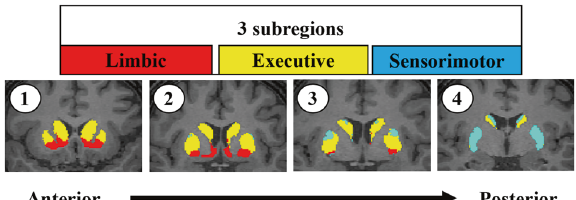
Fig. 1 Region of interest in the striatum. Striatal atlas re fl ecting the probabilistic anatomical connections between the cortex and the striatum, divided into three subregions. Each voxel in the striatum was classi fi ed according to the cortical region with the highest connection probability. These probabilities are de fi ned as the number of subjects with connection probabilities of >25% divided by the total number of